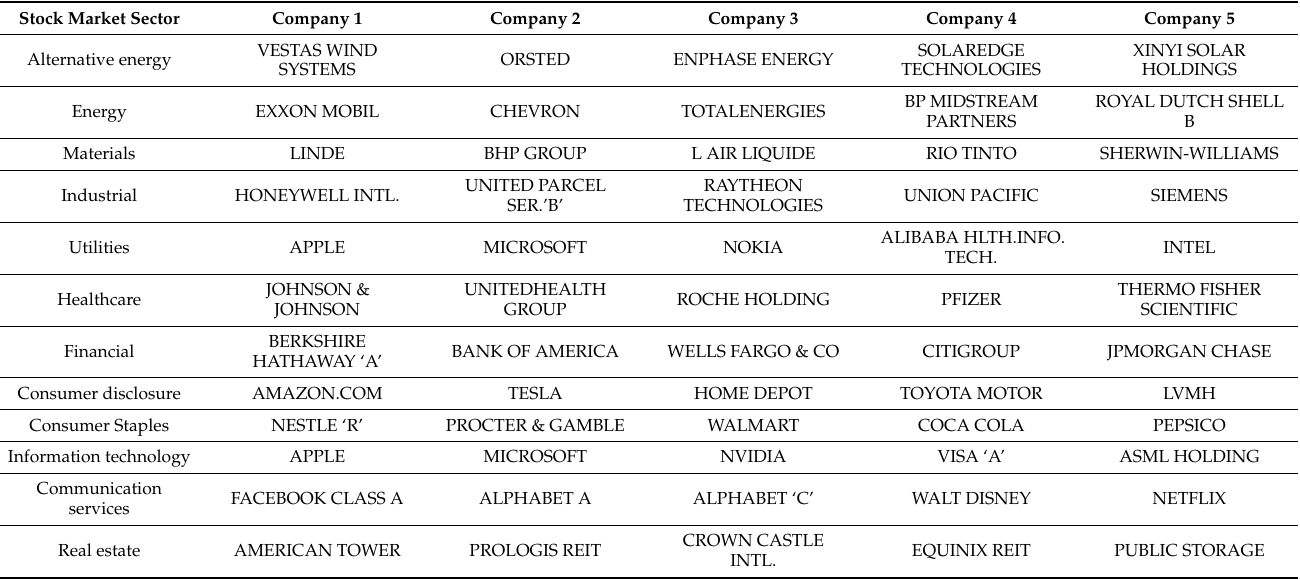
Table 1. Top five companies from alternative energy and main stock market sectors: based on MSCI stock market